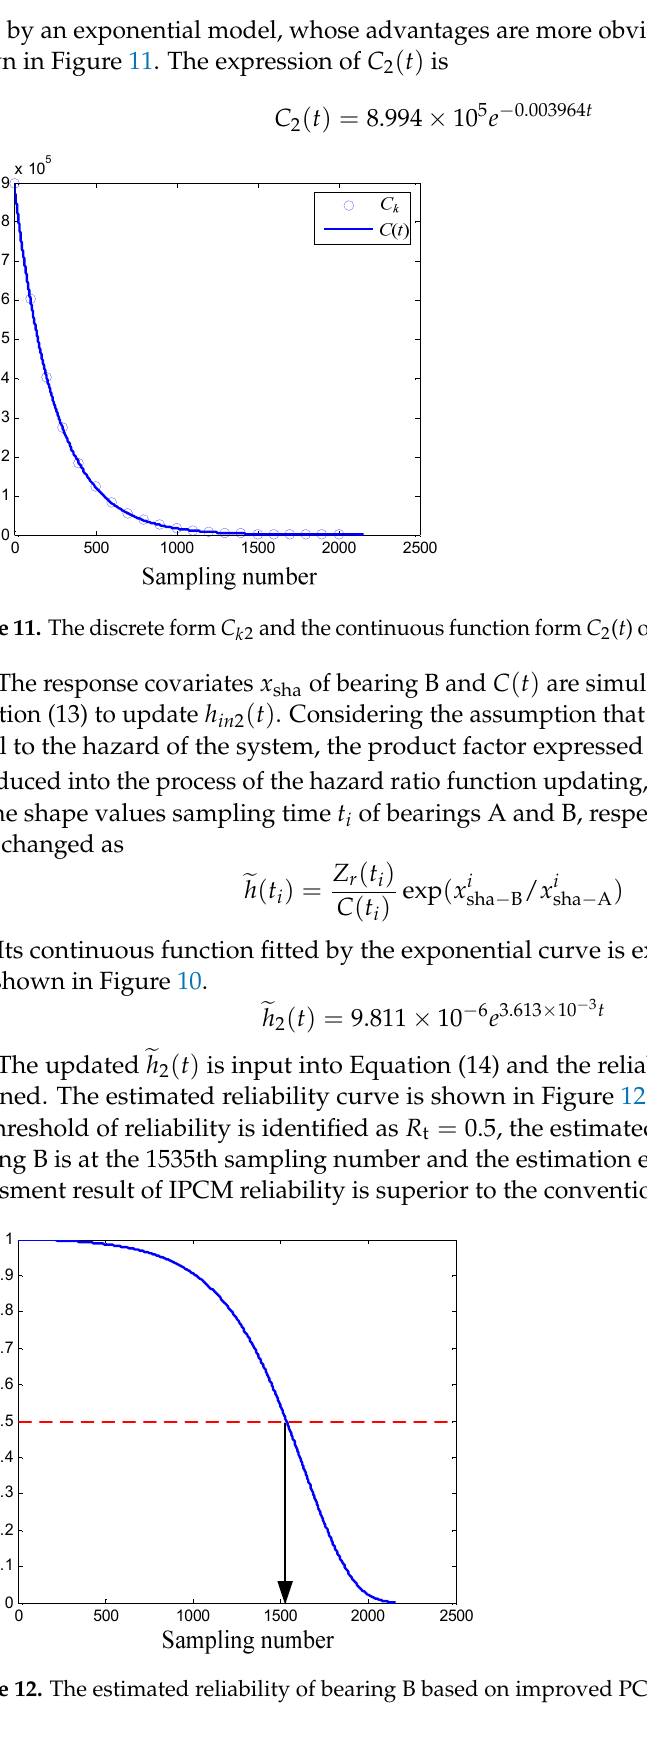
analysis method relies on the failure life data excessively. Fewer failure samples will lead to a large deviation between the PDF of the failure life date estimated by the hypothesis and the actual PDF of the failure life. In the subsequent reliability assessment process, this deviation will be gradually transferred to the calculation of ℎ (cid:3036)(cid:3041) ((cid:1872)) , (cid:1855)((cid:1872)) , and ℎ(cid:3560) (cid:2868) ((cid:1872)) , resulting in a large deviation between the actual evaluation reliability and the actual value. 5. Conclusions The present study proposes a new kind of reliability assessment method named as IPCM under the condition of sparse or zero failure data. LRM is employed to calculate the initial hazard function and PCM is then employed to estimate the equipment’s oper- ational reliability. Through the case studies of conventional PCM and IPCM to the aero engine rolling bearings, we can draw some conclusions as follows: (1) The LRM-based estimation method only needs acquiring the equipment’s response covariate vectors and their corresponding states without requiring specific me- chanical knowledge or making many assumptions about the PDFs of variables. It passes the process of the proportional factor identification between covariate and hazard rate so that it can avoid the influence of the subjective deviation.